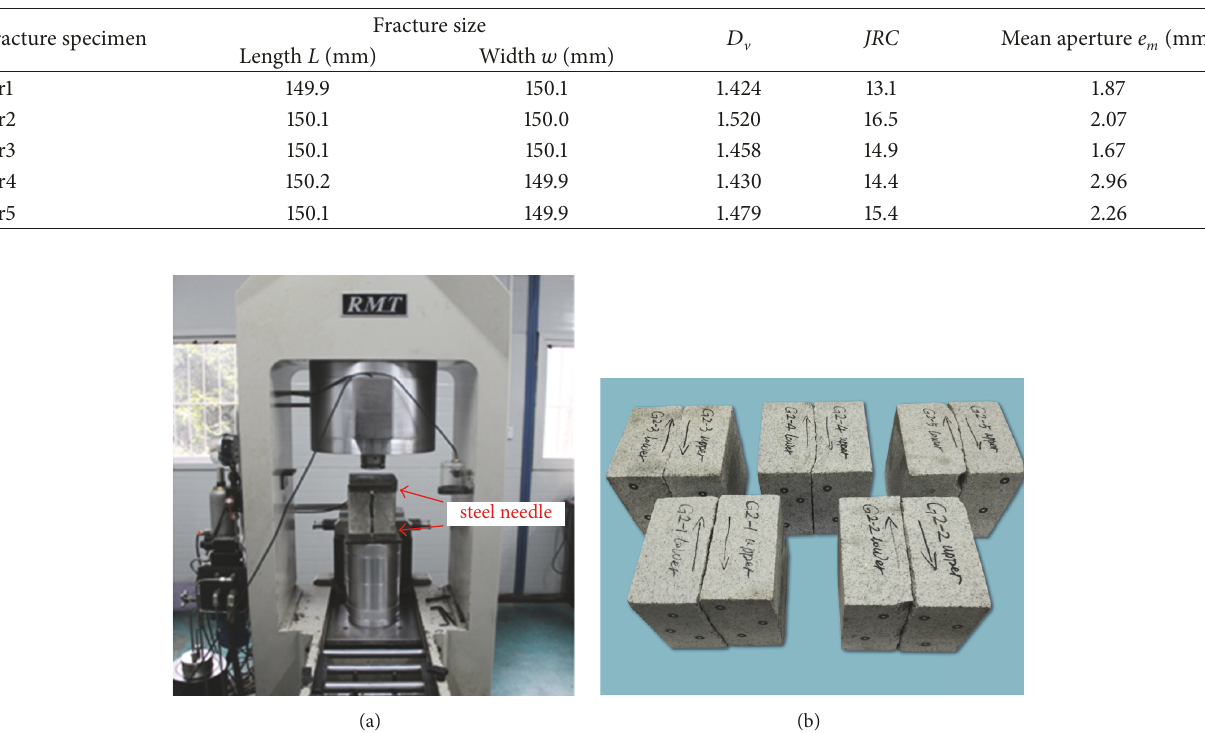
Table 1: Geometry parameters of initial closed fractures.